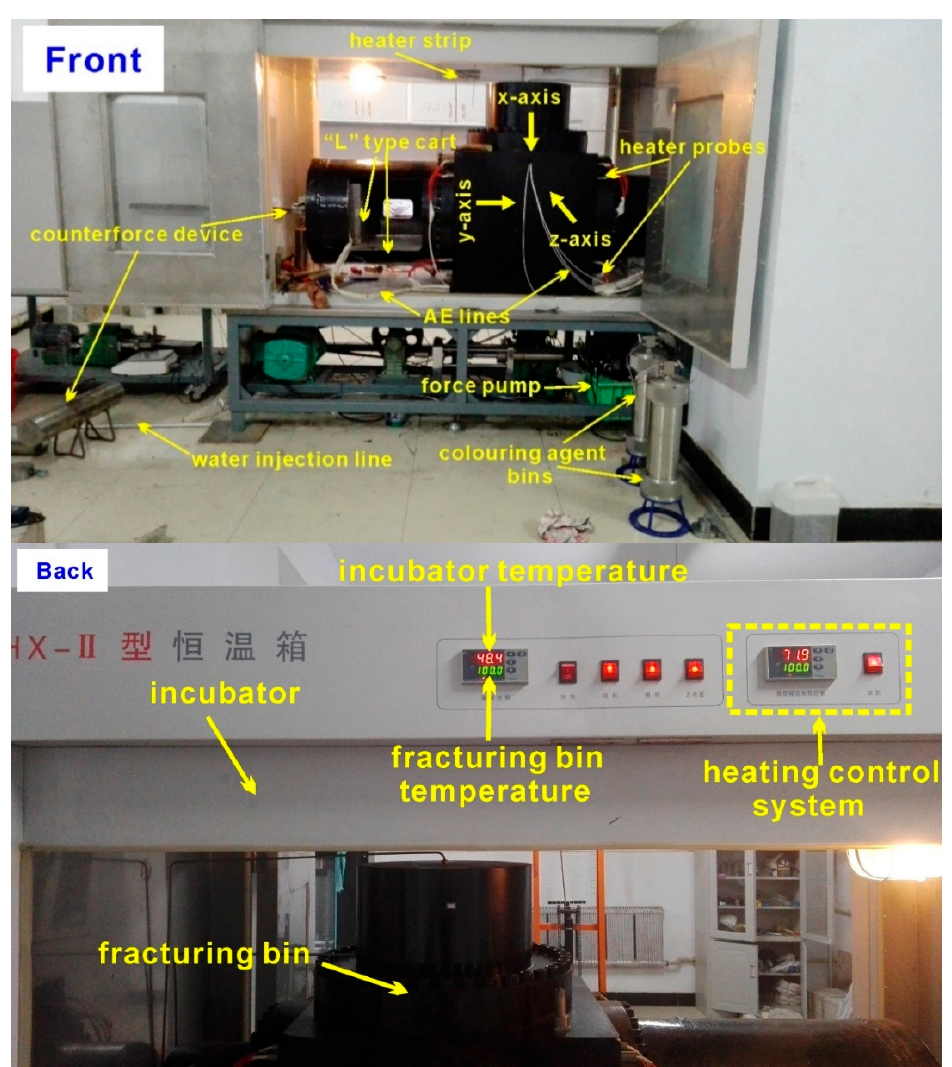
Figure 4. Large-size true triaxial hydraulic fracturing experiment system. The front view ( Front ) and the back view ( Back ) of the instrument are shown in the figure.